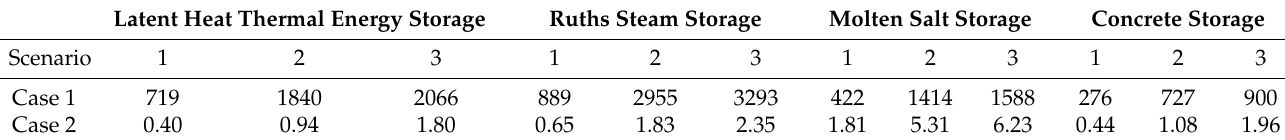
Table 8. Average total storage costs in M € for Case 1 and Case 2. 1: Low Cap./Low HL, 2: High Cap./Low HL, 3: High Cap./High